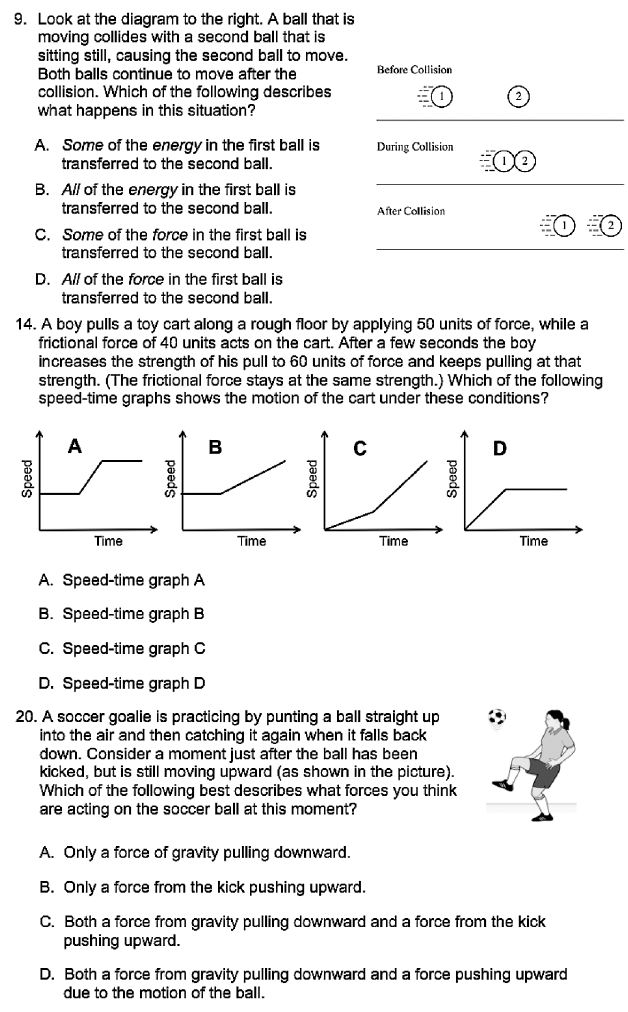
FIG. 15. Three questions from the Physical Science question-